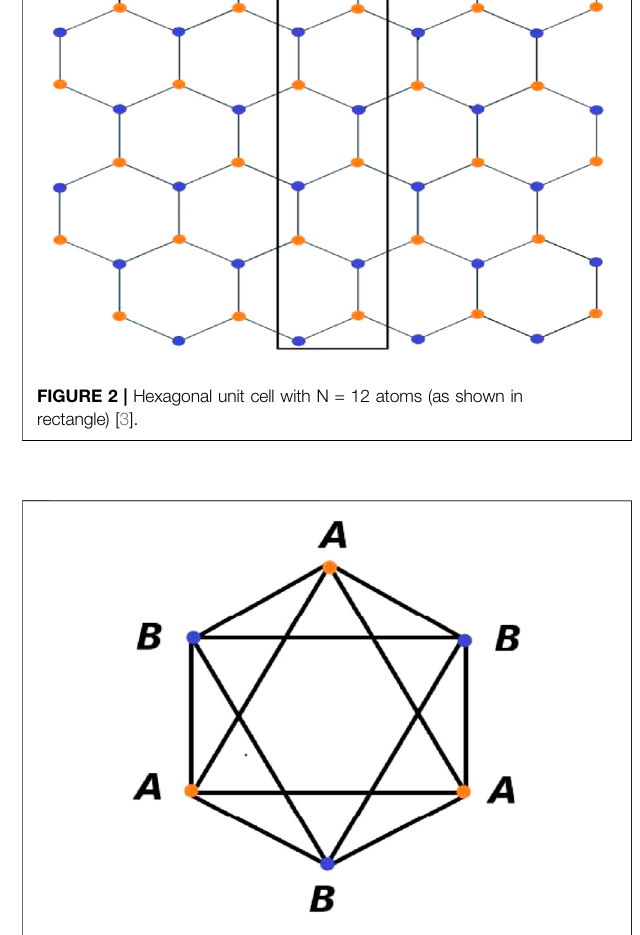
FIGURE 3 | Hexagonal structure with a basis of two atoms, A and B